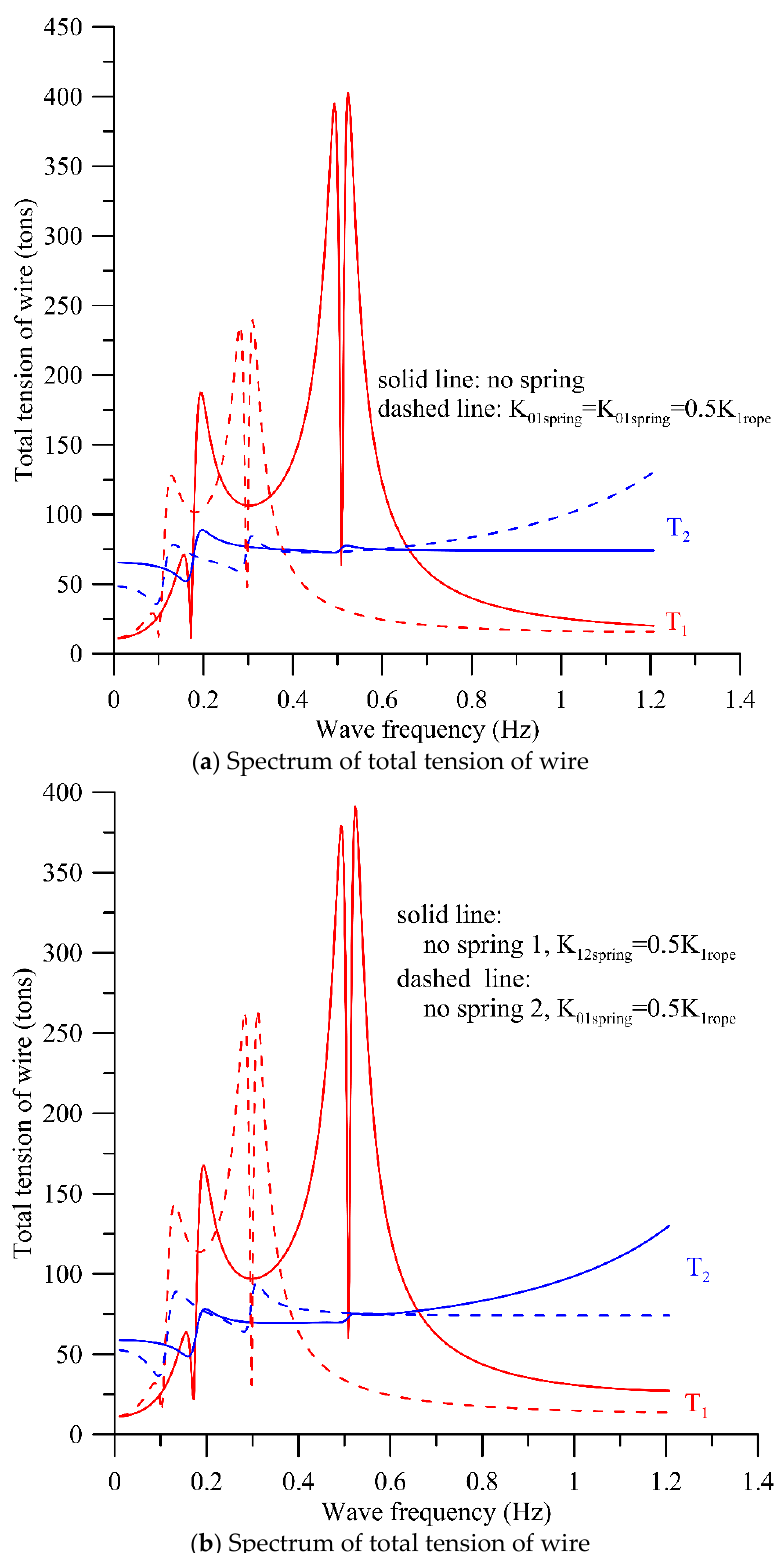
Figure 8. Effects of the buffer spring connecting to the ropes and the wave frequency f on the total tensions of rope, { T 1 , T 2 } . [ A BB = 7 m 2 , θ 1 = 40 ◦ , m ef f , x = 6.038 tons, m ef f , y = 9.714 tons, L 1 = 1929.1 m, other parameters are the same as those in Figure